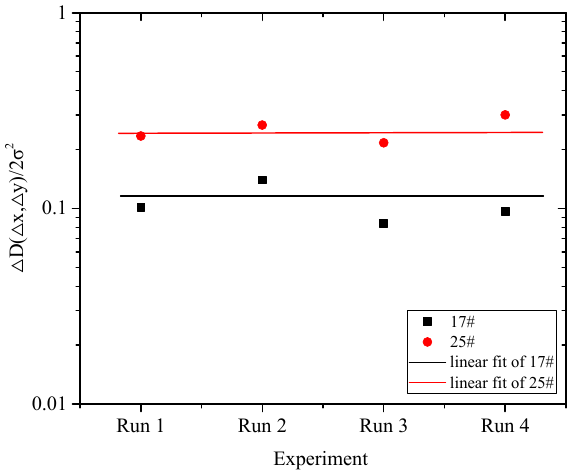
ff erence of the second-order structure functions of all Figure 16. The difference of the second-order structure functions of all runs. Figure 16. The di Figure 16. The difference of the second-order structure functions of all runs.